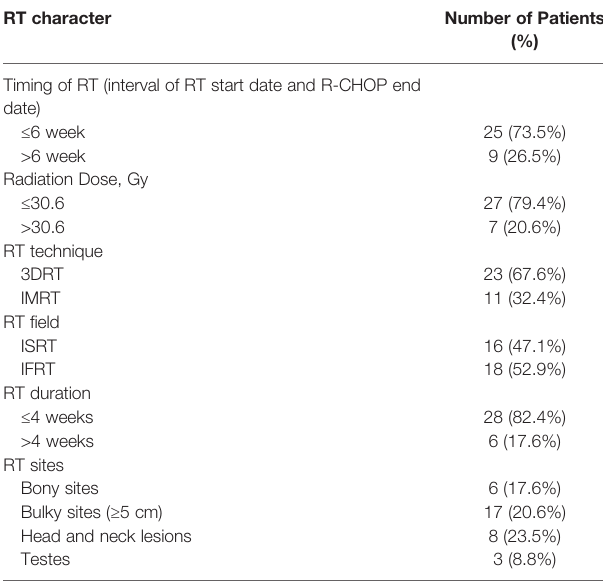
TABLE 2 | Characteristics of Radiation Therapy.